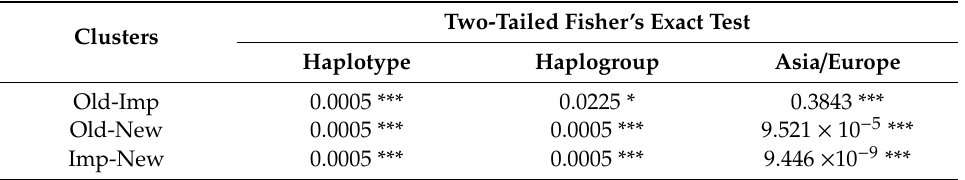
Table 5. Two-tailed Fisher’s exact test in groups of Old, Imp, and New. Clusters